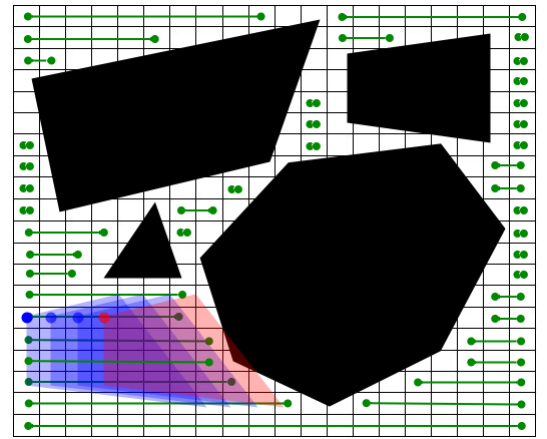
Figure 4. Sample four-threaded texture patch placement on BAM segments indicating free atlas spots (green). The leftmost blue position will be picked, and the red position collides with a previously placed polygon